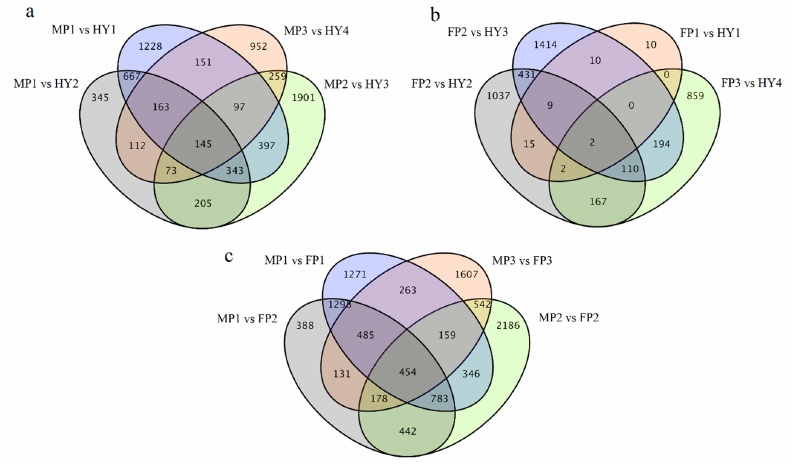
Figure 2. Venn diagram comparison of differentially expressed genes (DEGs) between hybrids and their parents. The common DEGs in different hybrids compared to their ( a ) male parent and ( b ) female parent, and ( c ) between female and male parent combinations used to generate the four different hybrids.